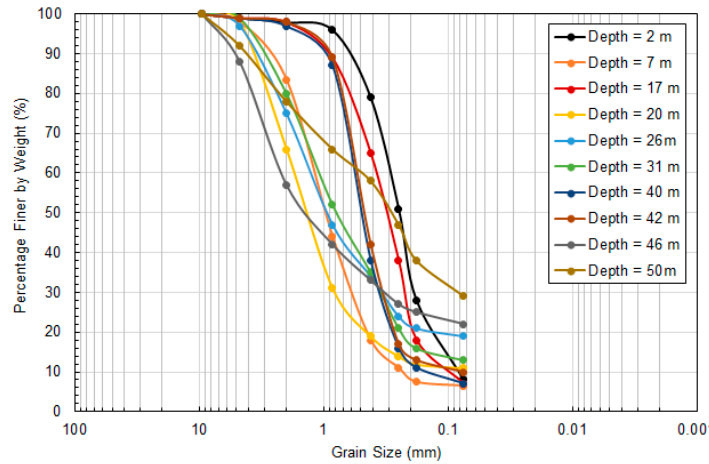
Figure 9. Sieve test and grain number for the Jubail site.